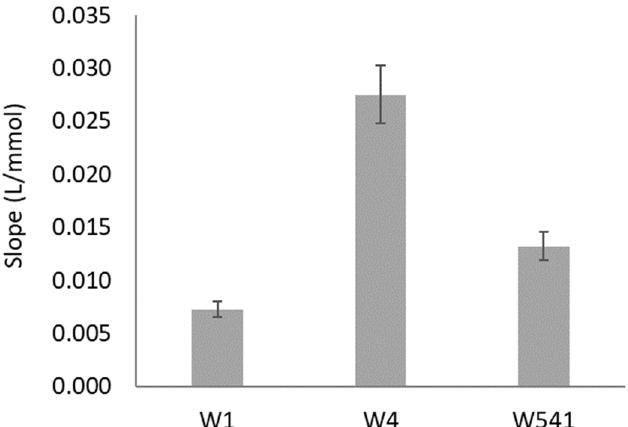
Figure 2. Study of filter paper type and porosity influence on the enzymatic reduction reaction.